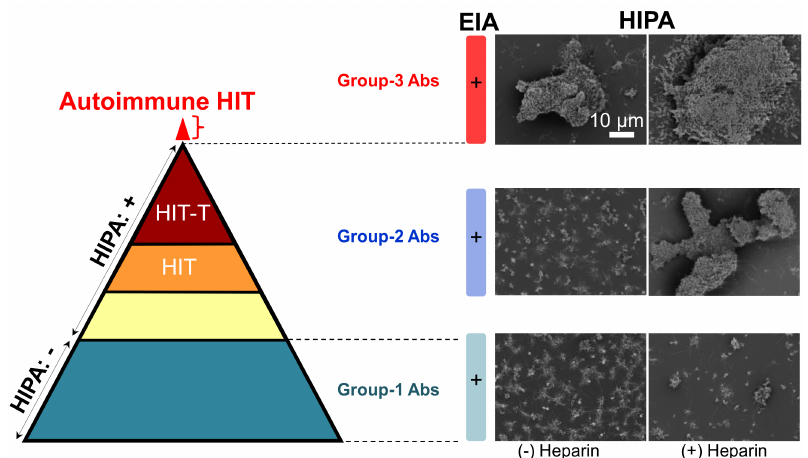
Figure 2. Reaction patterns of aPF4/H Abs. ( Left ) The pyramid shows antibodies of three groups. They are all positive in ELISA. Group-1 Abs (dark cyan) do not activate platelets in a functional assay ( − ). group-2 Abs contain different types of antibodies, i.e., some do not induce HIT (yellow), some induce HIT (orange), and some induce HIT with thrombosis (brown). Recent studies found an additional small subset of patient’s content autoimmune group-3 Abs (red). ( Right ) Scanning electron microscopy images showing platelet aggregates in the presence (+) or absence ( − ) of heparin. Group-1 Abs induce only small aggregates (bottom panel) reflecting the background platelet activation, group-2 Abs (middle panel) cause large aggregates only in the presence of heparin, and group-3 Abs induce large aggregates even in the absence of heparin. Scale bar is applied to all images. Adapted from